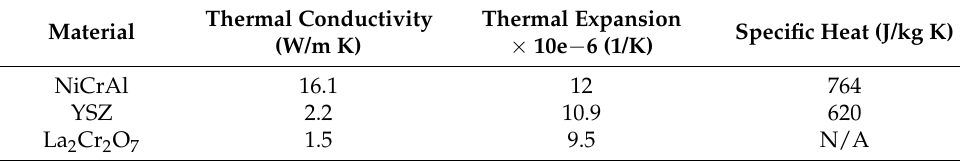
Figure 5. Layers in the thermal barrier coating for the AHB. Table 1. Thermal properties of materials [21].